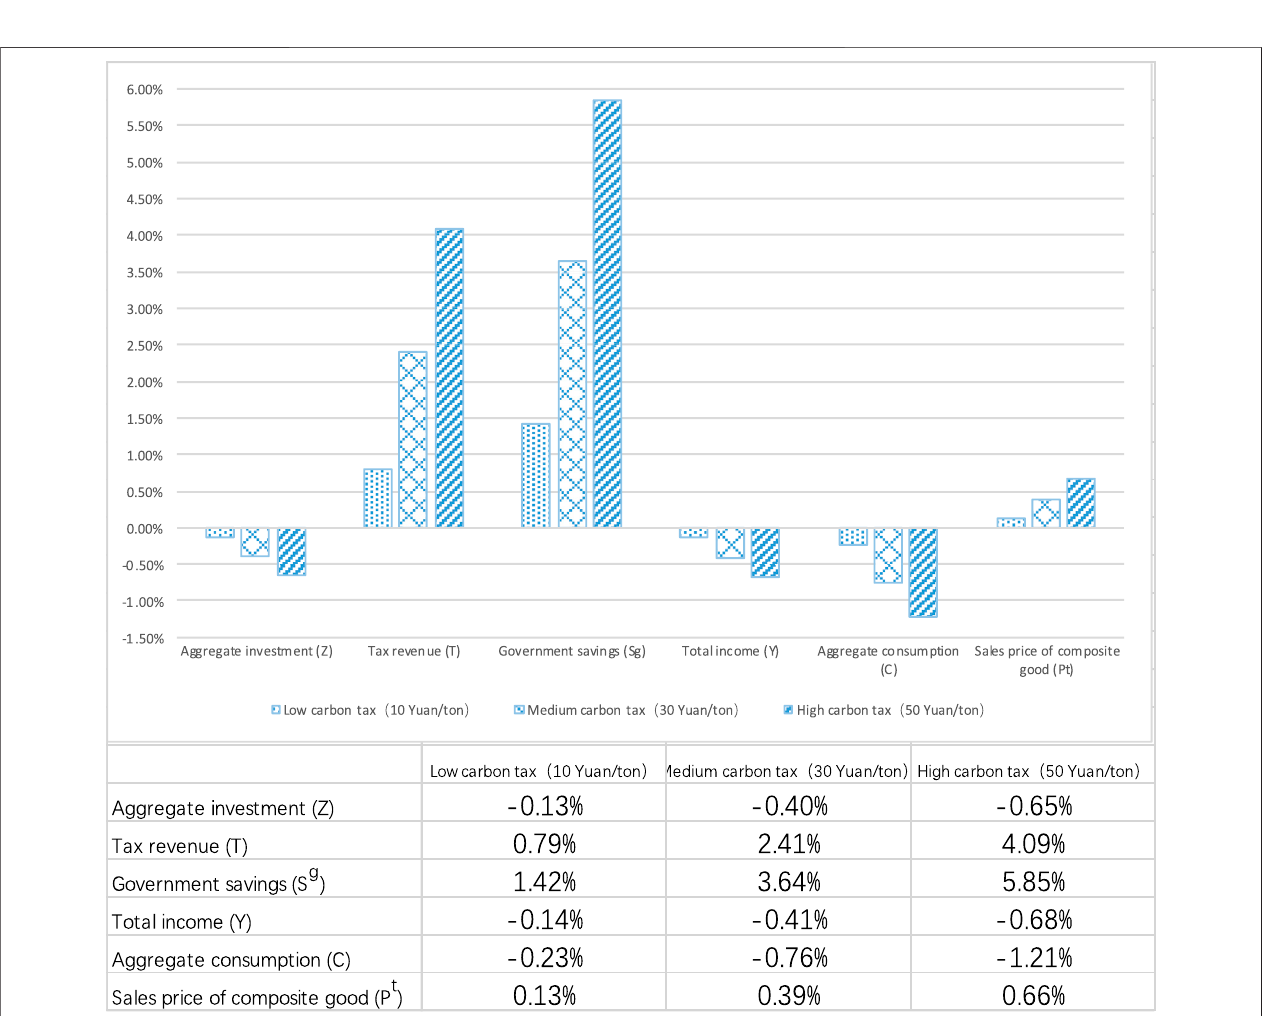
FIGURE 3 | Impact on macroeconomic variables in the carbon tax policy